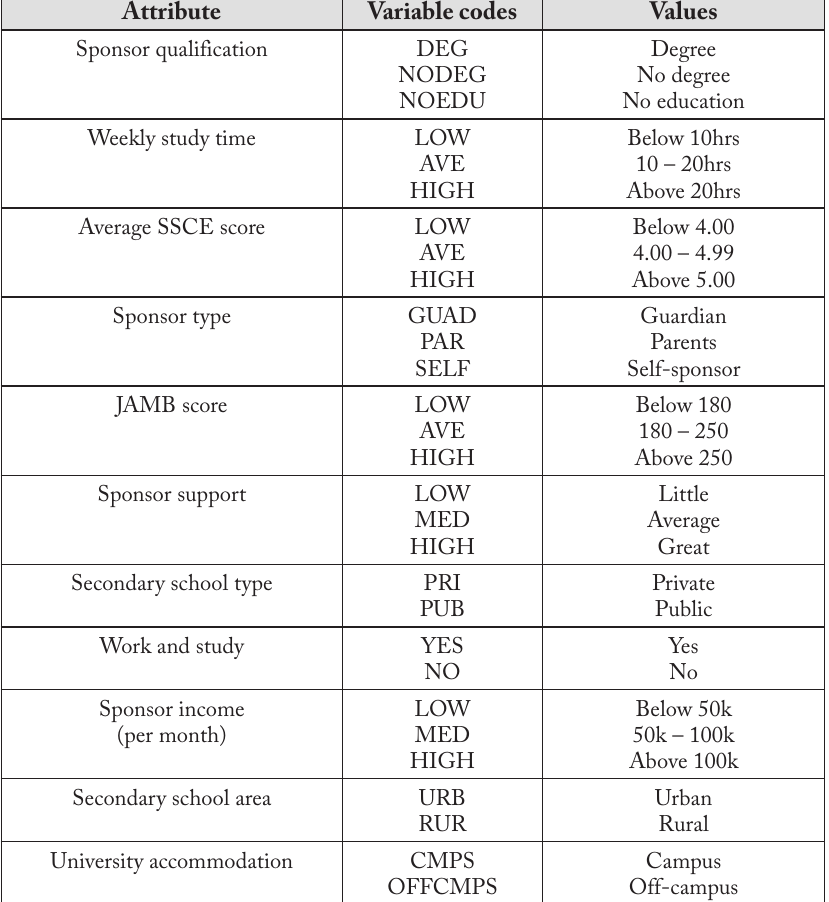
Table 8: Selected attributes